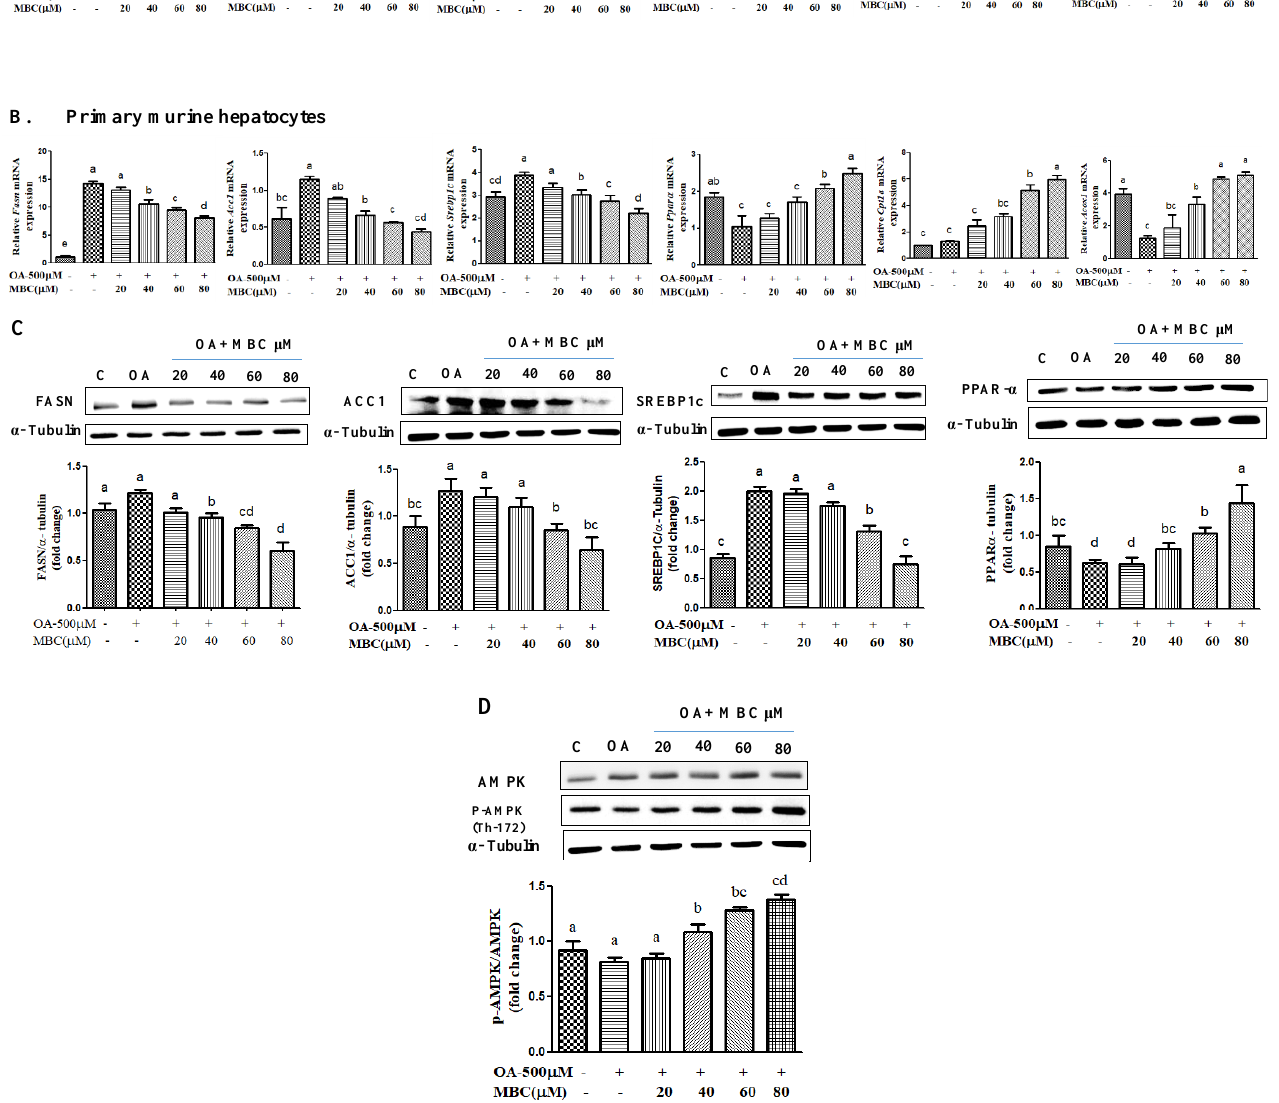
Figure 3. Effect of methyl brevifolincarboxylate (MBC) on expression of lipogenesis and lipid oxidation mRNA and proteins in OA-treated SK-HEP-1 cells ( A ), and primary murine hepatocytes ( B ) . Cells were treated with 0.5 mM of OA, and different concentrations of MBC (0, 20, 40, 60, and 80μM) for 48 h. Total RNA was isolated using a GENEzol reagent and mRNA was measured using qRT-PCR. Target gene mRNA levels were normalized to a reference gene β-actin. ( C ) Protein expression of FASN, ACC1, SREBP-1c, PPAR-α and ( D ) p-AMPK were detected by Western blot. All results are expressed as mean ± SD of three independent experiments. Data bars with similar letters were not significantly different ( p ≤ 0.05).